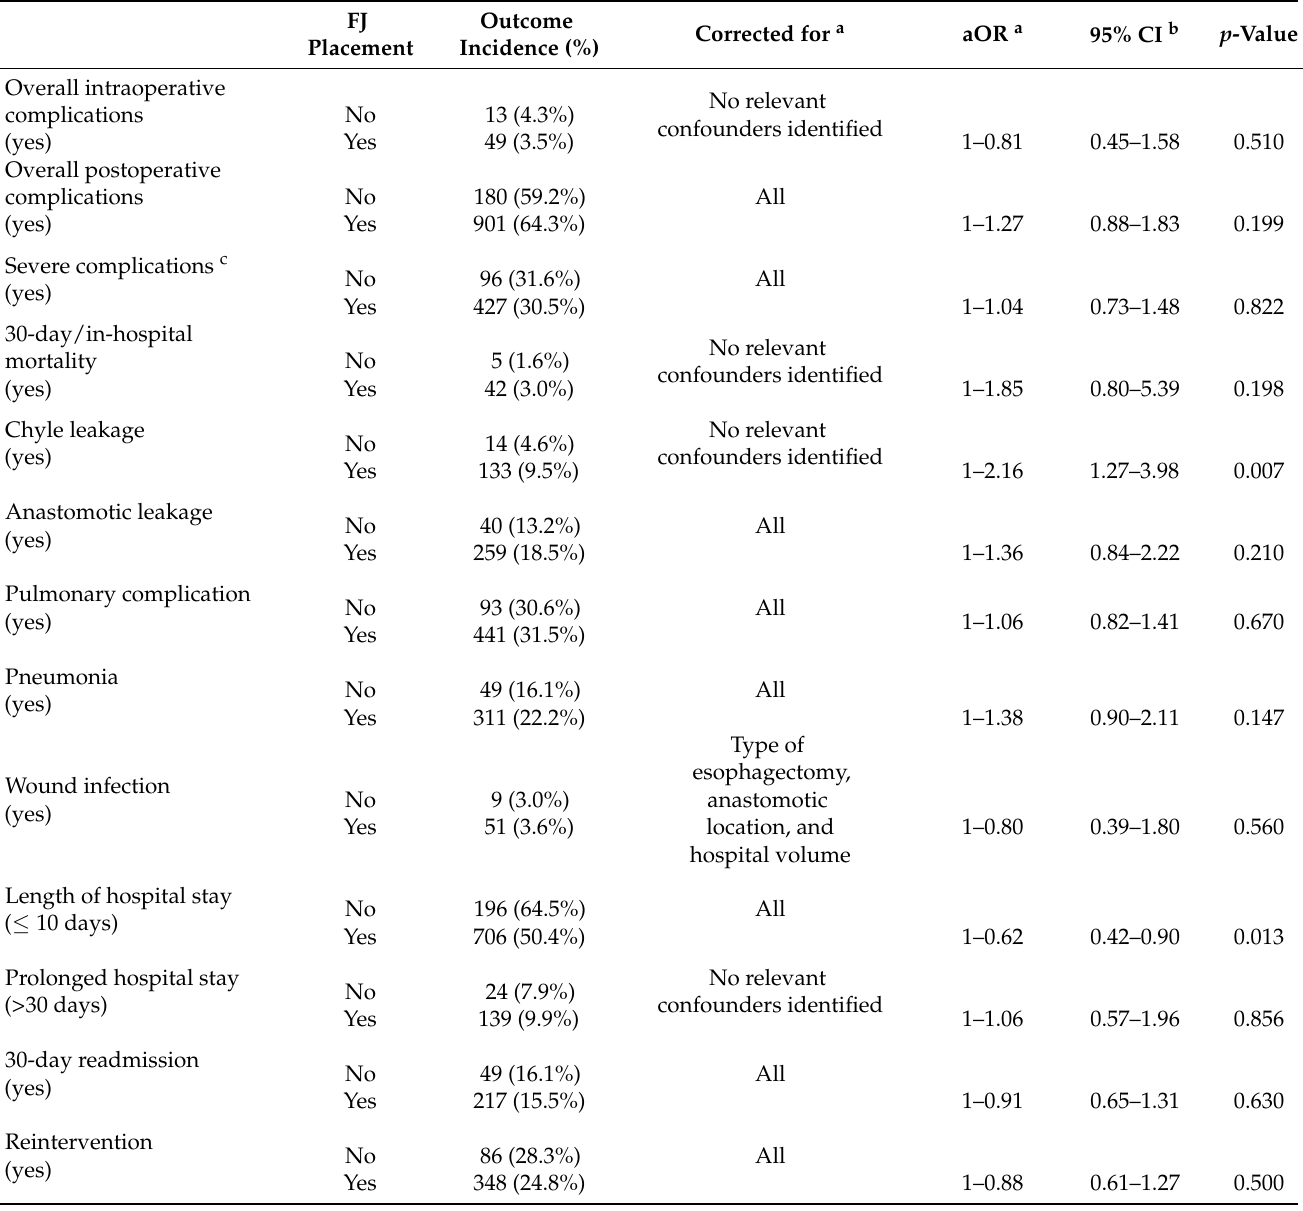
Table 2. Multilevel multivariable logistic regression analyses of short-term surgical outcomes after minimally invasive esophagectomy compared between patients without and with feeding jejunos- tomies (FJ).